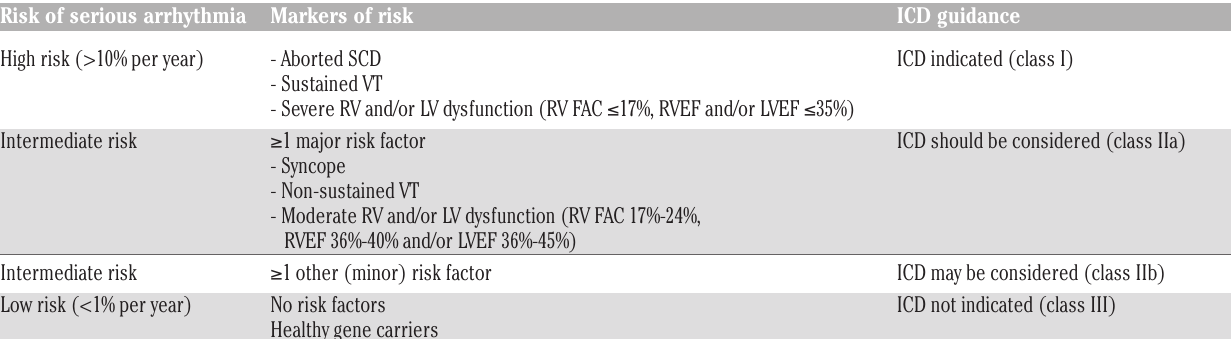
Table 3. Risk stratification and indications for implantable-cardioverter defibrillator (ICD) therapy. Risk of serious arrhythmia Markers of risk ICD